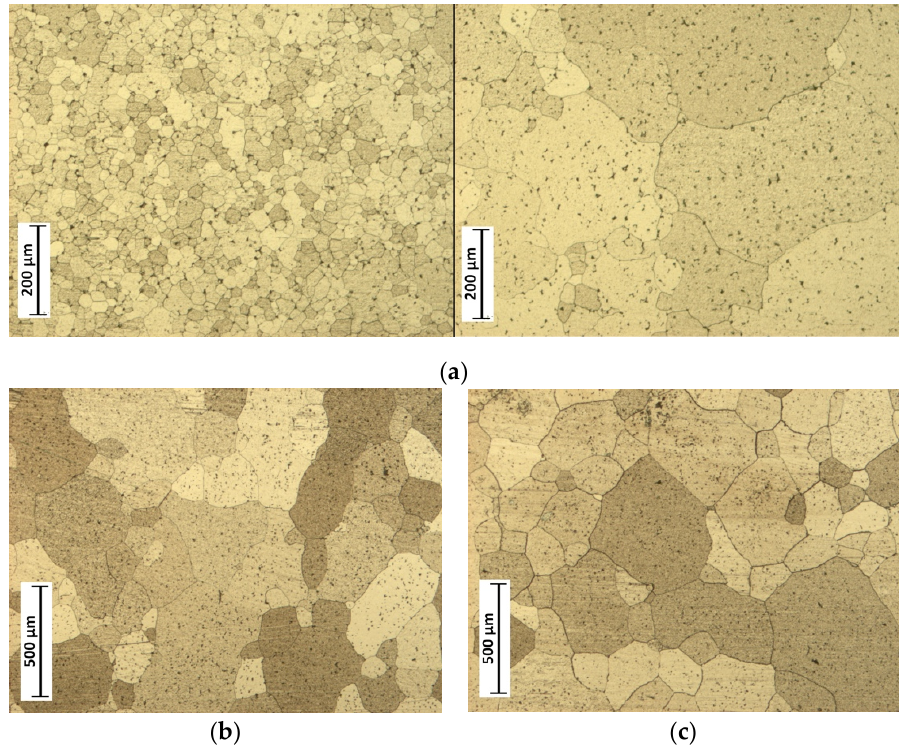
Figure 6. Microstructures after chemical etching of molybdenum powder (Mo-45) sintered at 1900 °C under 70 MPa pressure: ( a ) without holding (left: shell, right: core), ( b ) 10 min and ( c ) 30 min.